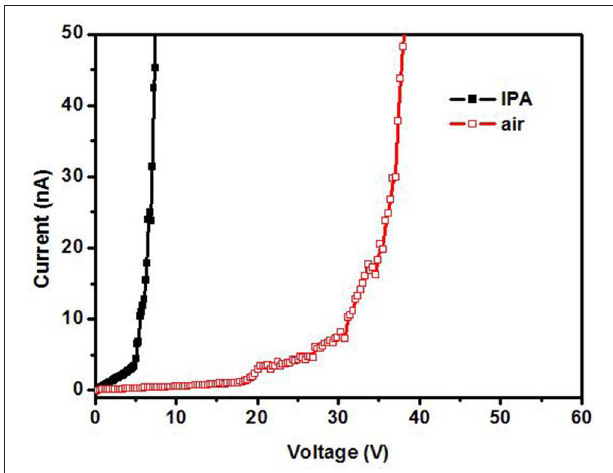
FIGURE 9 | Ionization in IPA and air for a 5nm Mn decorated ZnO nanorods electrode under magnetic